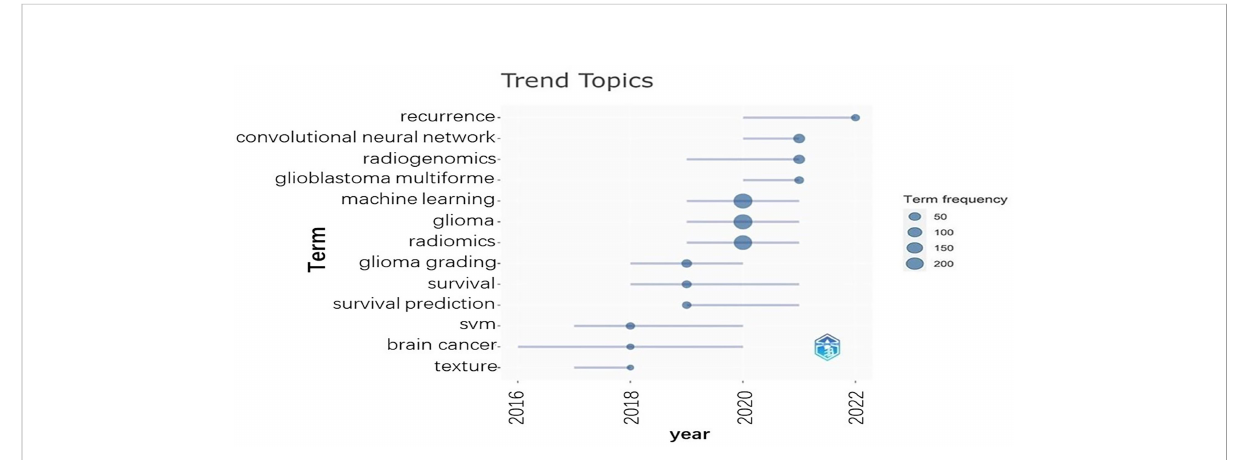
FIGURE 5 The horizontal axis is the year. The vertical axis represents the topics. The dots represent the term